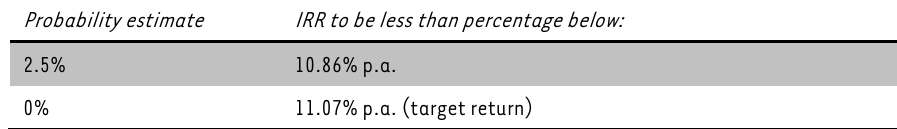
TABLE 11: Probabilities of downside IRR of the investments in Set D Probability estimate